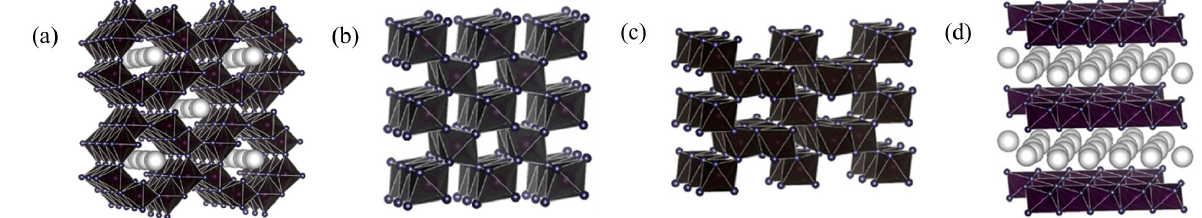
Figure 3. Crystalline structure schematic diagrams of ( a ) α -MnO 2 ; ( b ) β -MnO 2 ; ( c ) γ -MnO 2 ; ( d ) δ -MnO 2 . Reprinted with permission: Elsevier 2020 [90].